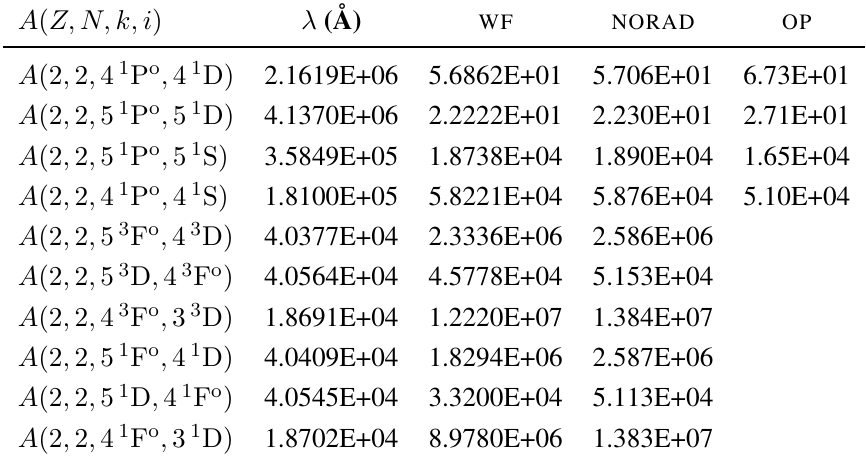
Table 3. A -values (s − 1 ) for E1 transitions in He I that show discrepancies larger than 10% with respect to the critical compilation of [88] ( WF ). NORAD : rates from the NORAD database computed with the R -matrix method in a 10-state approximation [95]. OP : results from the OP [129] listed in TOPbase. Wavelengths are determined from the NIST term